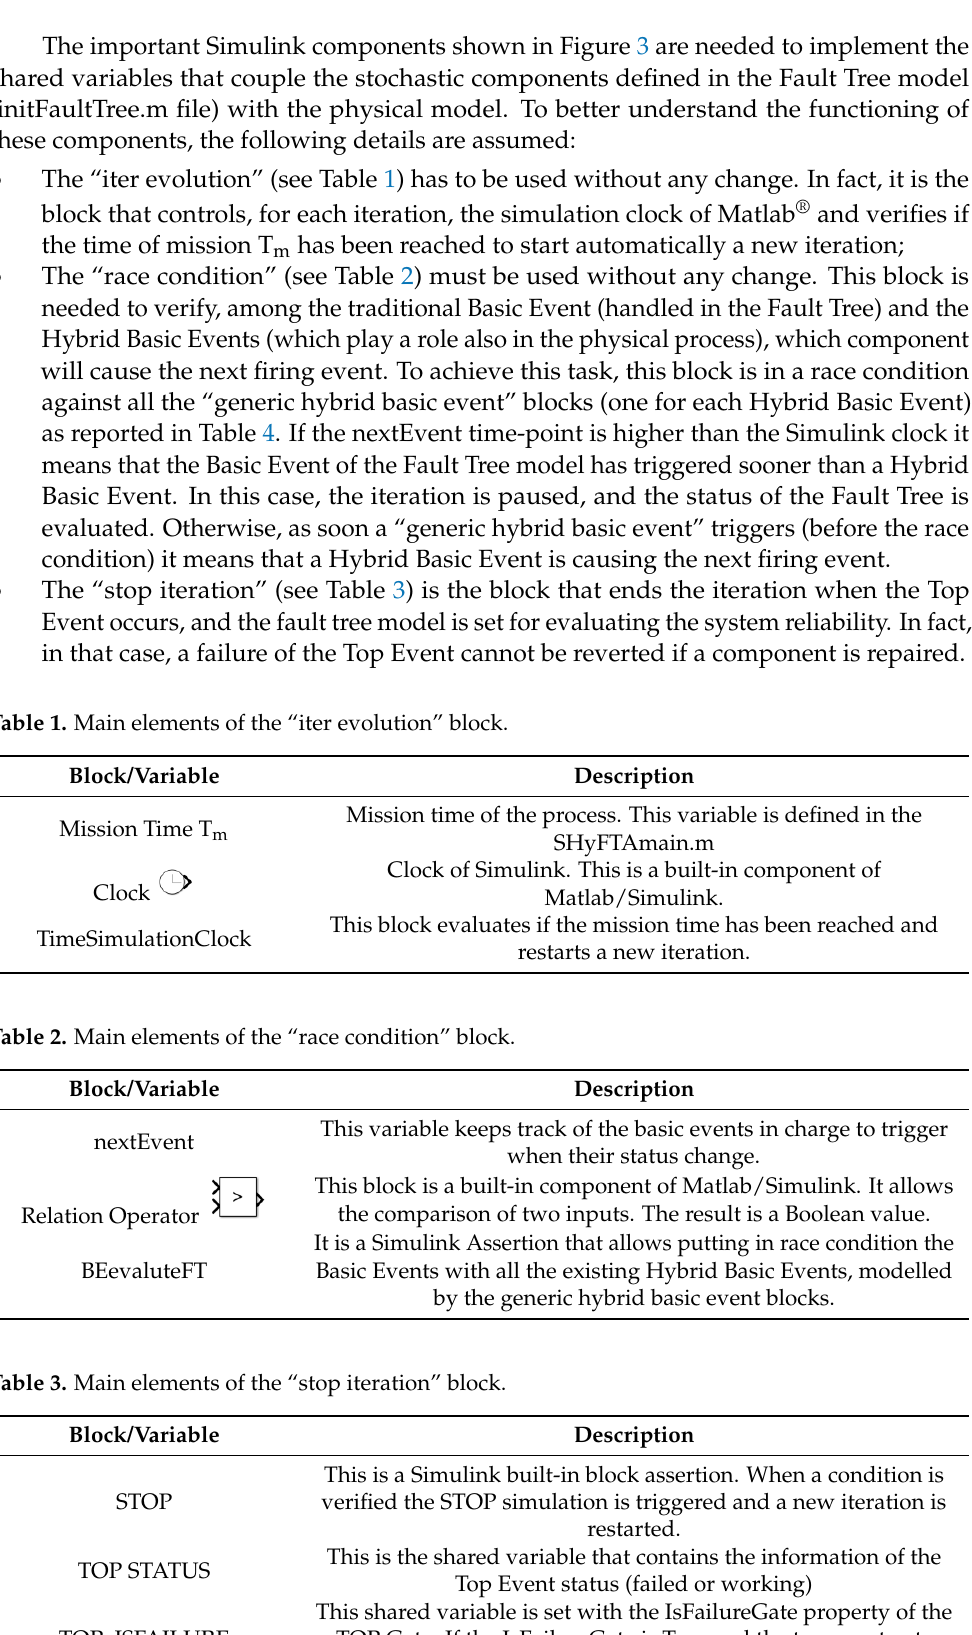
Figure 3. SHyFTA_TEMPLATE.slx file of the SHyFTOO library package.